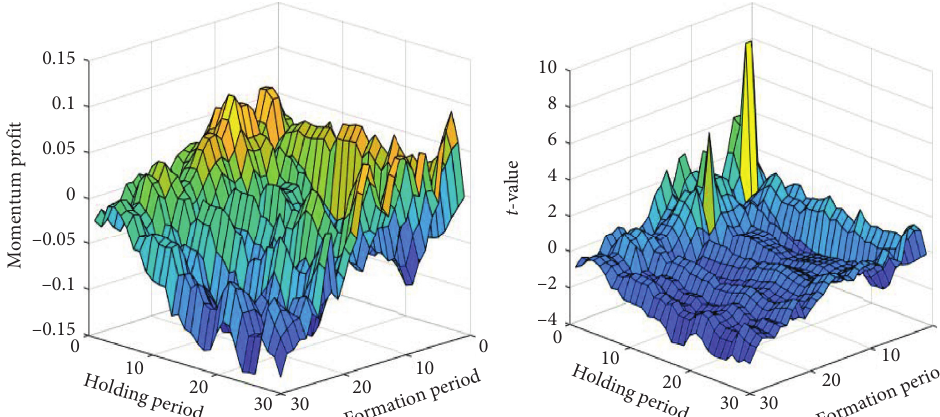
Figure 10: Highest accumulative relative order imbalance in extensions of the B-share market. This figure shows the momentum profits and t -statistics under the highest accumulative relative order imbalance in extensions of the B-share market. The formation and holding periods, respectively, range from 1 day to 30 days.